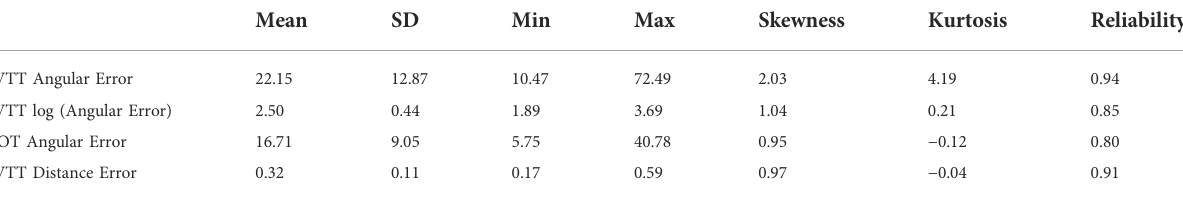
TABLE 2 Descriptive statistics for all measures at the participant